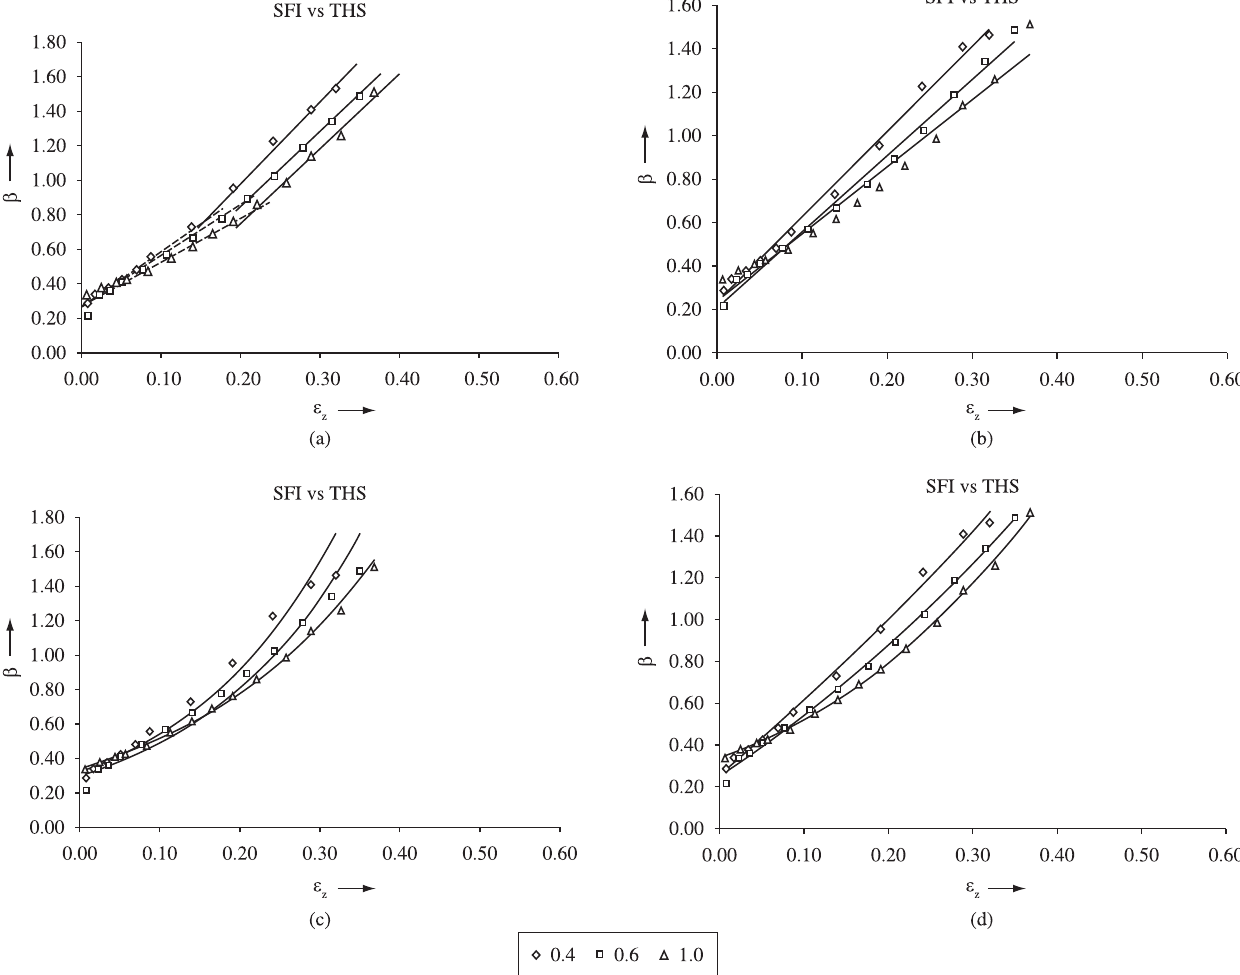
; b) relationship between β and e z – parabolic curve fitting. z z